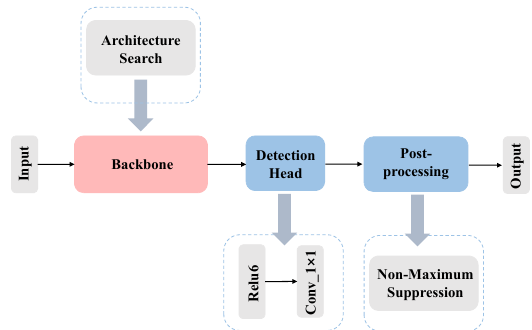
Figure 2. Overview: ship target